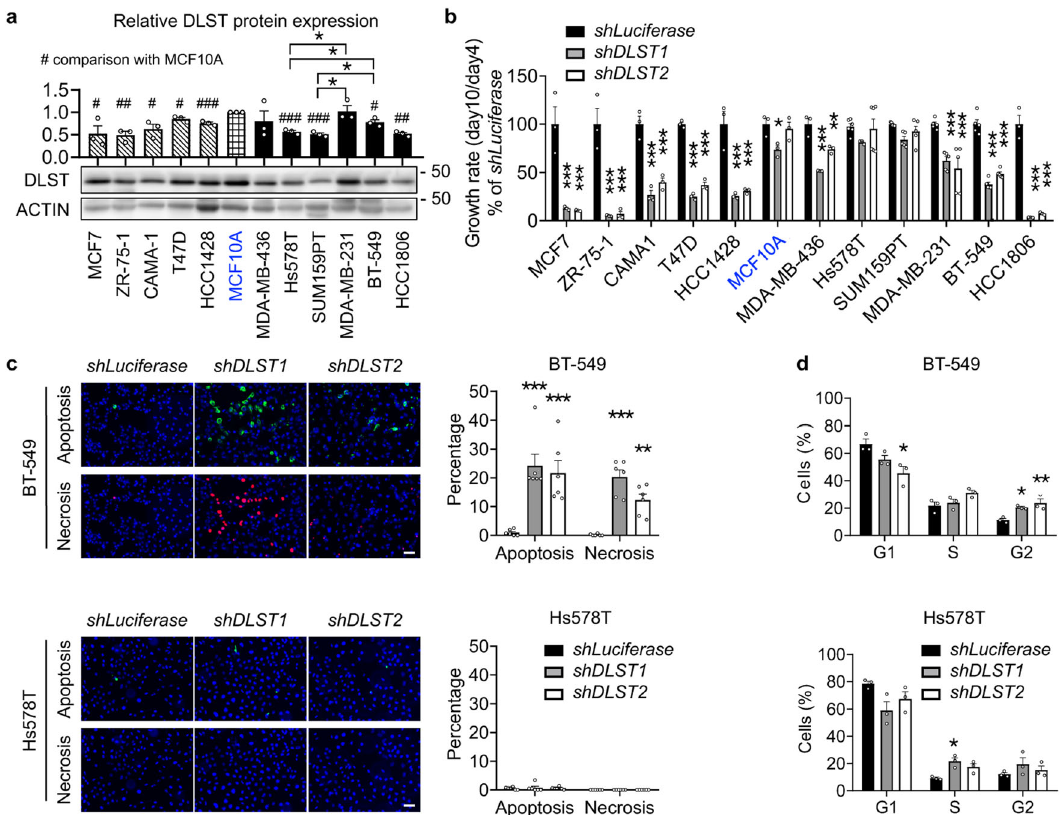
Fig. 2 Human TNBC cell lines exhibit differential responses to DLST depletion. a Semi-quantitative western blotting analysis shows DLST expression in fi ve human ER + cell lines (striped bars), a non-transformed mammary gland MCF10A cell line (blue font), and six human TNBC cell lines (black bars), with ACTIN serving as the loading control ( n = 3 of independent experiments). # in the bar fi gure indicates signi fi cant differences in DLST expression of breast cancer cell lines when compared to MCF10A cells. b Cell growth rates of cell lines in ( a ) transduced with shLuciferase , shDLST1 , or shDLST2 hairpin ( n = 3 – 6 per group). The knockdown ef fi ciency was validated by western blotting shown in Supplementary Fig. 5a, c. c Apoptosis and necrosis of TNBC cells were assessed at day 5 post-transduction by Annexin-V (green) and Ethidium homodimer III (red) staining, respectively, with DAPI (blue) staining for all cells. Representative images of BT-549 and Hs578T cells (left) together with their quanti fi cation (right) were shown ( n = 6 per group). Scale bars = 20 µ m. d Cell cycle distribution of BT-549 and Hs578T cells after DLST knockdown was shown as the percentage of cells in each cell-cycle phase ( n = 3 biological samples). Data in ( a – d ) are presented as mean ± s.e.m. One-way analysis of variance (ANOVA) in ( b , d ) and an unpaired two-tailed t -test in ( a , c ) were used for statistical analyses. * or # P ≤ 0.05, ** or ## P ≤ 0.01, *** or ### P ≤